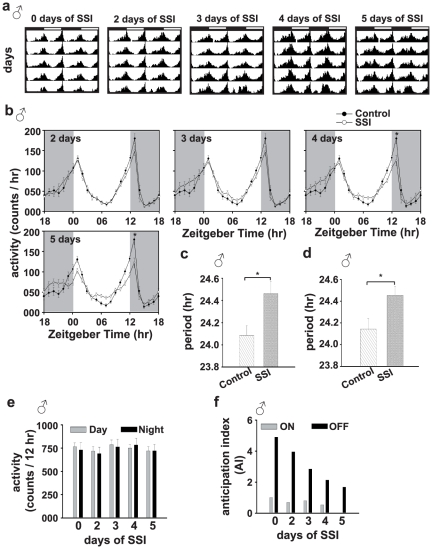
Socio-sexual interactions (SSI) reduce evening activity peak and lengthens clock period in males.(a) Average actograms of males following 0 (control), 2, 3, 4, or 5 days of SSI. (b) Activity profiles of males following 0–5 days of SSI. Zeitgeber Time (in hours) is plotted along x-axis, while activity (in counts in one hour bins averaged across five days) is plotted along y-axis. (c) The circadian period of locomotor activity rhythm of males following 5 days of SSI is lengthened compared to control males (p<0.01). (d) Circadian period of males kept in same sex groups (under light/dark – LD cycles) following 5 days of SSI for 8 days. The circadian period of SSI males is significantly lengthened compared to control males (p<0.02). (e) Cumulative daytime and nighttime activity of males subjected to 0, 2, 3, 4, or 5 days of SSI. The number of days of SSI is plotted along x-axis and daytime or nighttime activity (in counts/12 hr average across five successive days) along y-axis. (f) Anticipation to lights-on and lights-off as measured by Anticipation Index (AI) of male flies subject to 0, 2, 3, 4, or 5 days of SSI. The shaded area indicates night and the empty area day of laboratory LD cycles. The error bars are standard error around the mean (SEM). Asterisks indicate significant differences with p values<0.05.